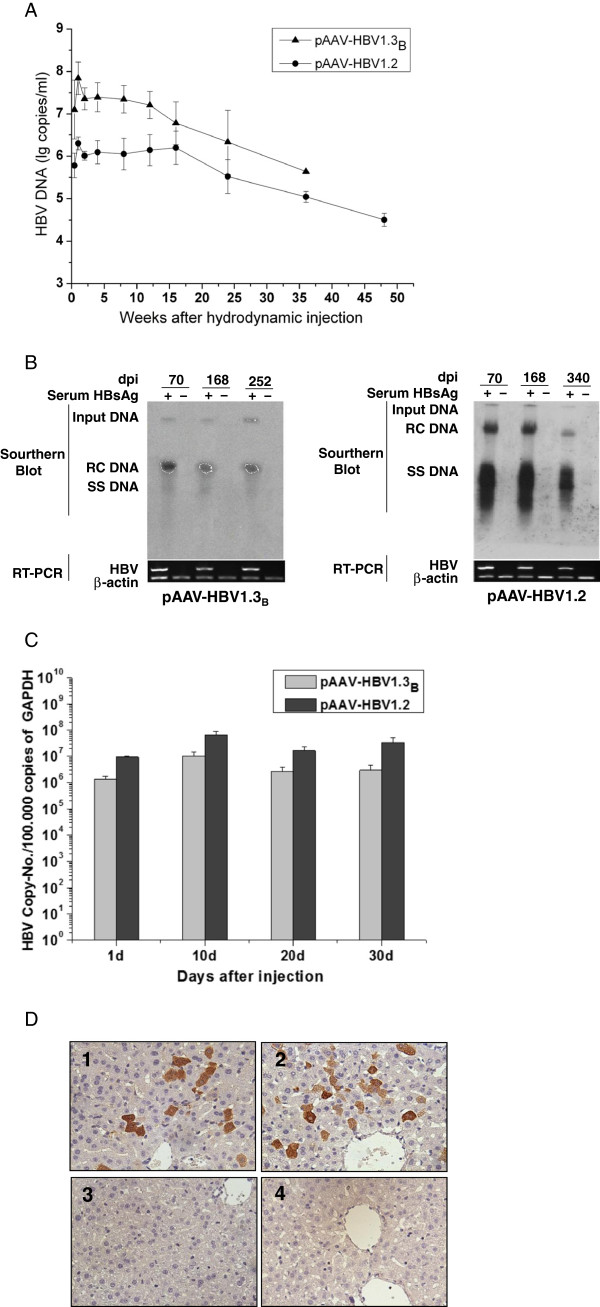
HBV replication and gene expression in vivo after HI with pAAV-HBV1.3B or pAAV-HBV1.2. 10 μg of pAAV-HBV1.3B or pAAV-HBV1.2 were injected into the tail veins of C57BL/6 mice. pAAV-HBV1.3B group included 14 mice and pAAV-HBV1.2 group included 9 mice. (A) Real-time detection of HBV DNA in mouse sera at the indicated time points (the number of the mice ≥ 3). (B) Southern blot analysis with 20 mg of total DNA extracted from liver tissues of the mice HI with pAAV-HBV1.3B or pAAV-HBV1.2 at different time points after HI. All DNA samples were treated with RNase before subjected to agarose gel electrophoresis. Bands corresponding to the expected size of the input HBV plasmids, relaxed circular (RC) and single-stranded (SS) HBV DNAs are indicated. (C) Real-time PCR detection of HBV DNA levels in the liver of the mice after HI. (D) Immunohistochemical staining of the liver sections for HBcAg in hepatocytes of HBsAg-positive or HBsAg-negative mice at day 252 after HI with pAAV-HBV1.3B (1, HBsAg positive mice and 3, HBsAg negative mice) and at day 340 after HI with pAAV-HBV1.2 (2, HBsAg positive mice and 4, HBsAg negative mice) (Original magnification: 400X).